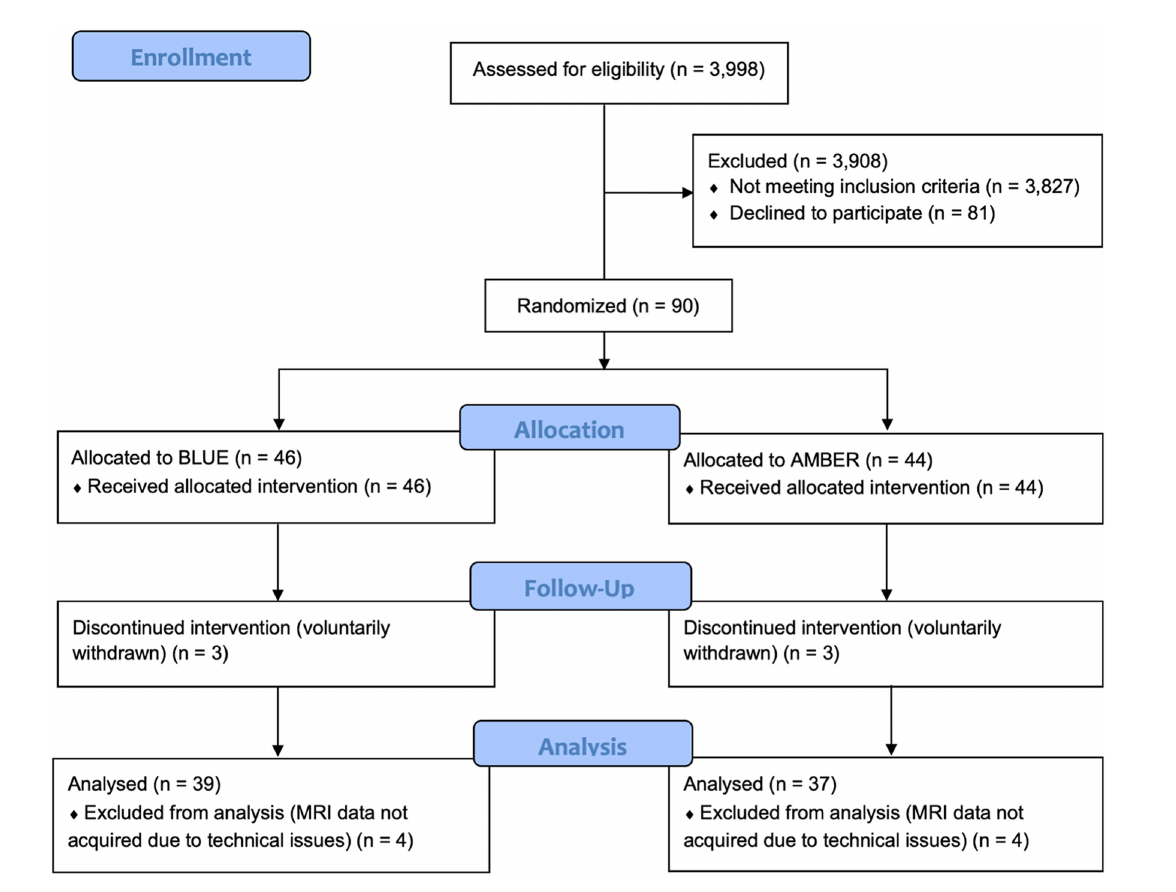
FIGURE1 CONSORT diagram showing the assignment of participants to each condition. Following an intention-to-treat approach, all participants who were randomly assigned to a treatment condition were analyzed, with the exception of participants who withdrew from the trial prematurely ( n = 3 per condition) or did not have usable neuroimaging scans at both sessions ( n = 4) per